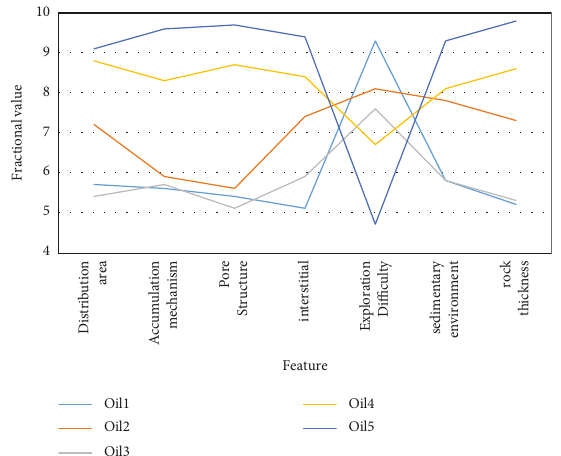
Figure 6: Comparative analysis of the characteristics of different oils.